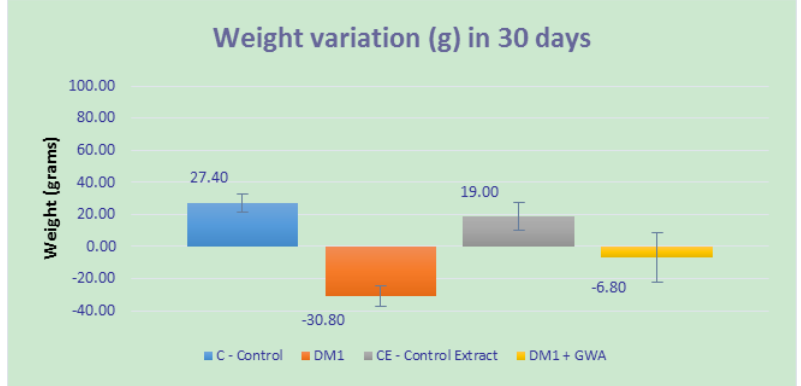
Figure 1. Weight variation (in grams) from animals since beginning of treatment until experimental end. p < 0.05 between C and CE groups; p < 0.01 between DM1 and DM1 + GWA (hydroethanolic extract) groups.